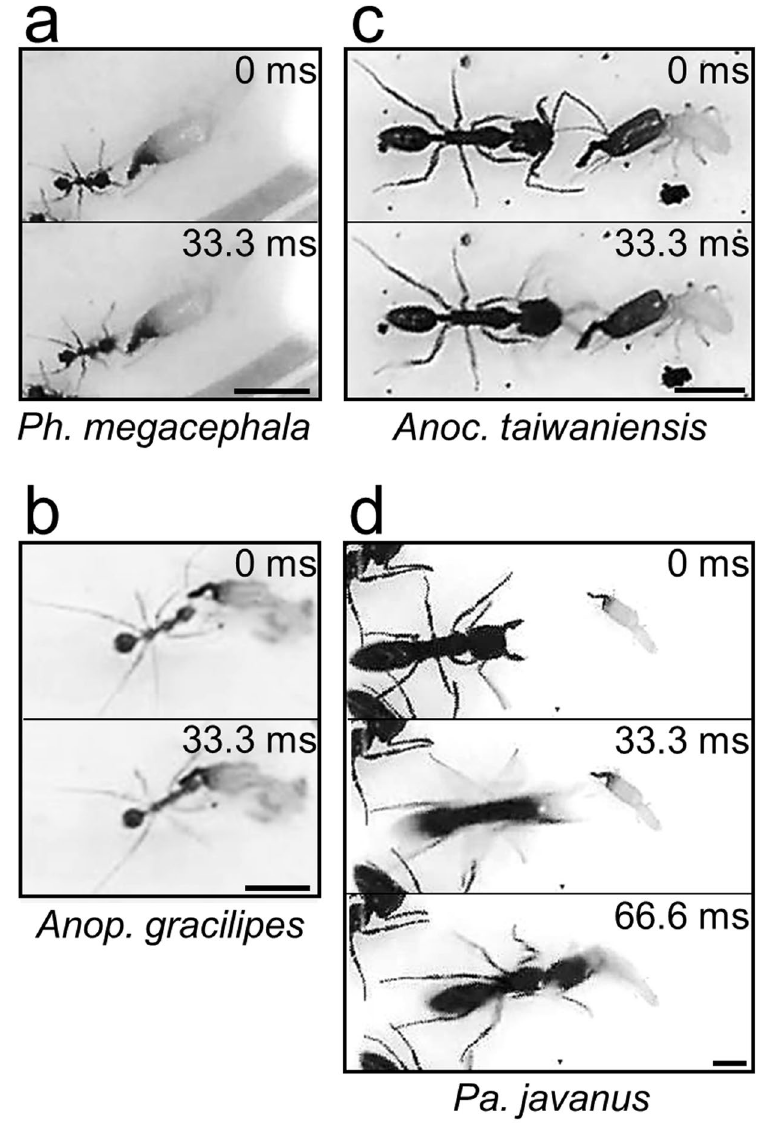
Figure 5. Attack behaviours of ( a ) Pheidole megacephala , ( b ) Anoplolepis gracilipes , ( c ) Anoc. taiwaniensis , and ( d ) Pa. javanus on Pe. nitobei . The attacks of Ph . megacephala , Anop . gracilipes , and Anoc . taiwaniensis were initiated after their antennae touched the mandibles or head of Pe. nitobei (0 ms), with a short distance between the heads of these three species and the mandible tip of Pe. nitobei (approximately 0.6–1.5 mm). By contrast, Pa. javanus initiated an attack when its head was approximately 6.8 mm away from the mandible tip of Pe. nitobei (0 ms). This attack was followed by rapid movement toward the termite’s head (33.3 ms) and clamping at its mandibles (66.6